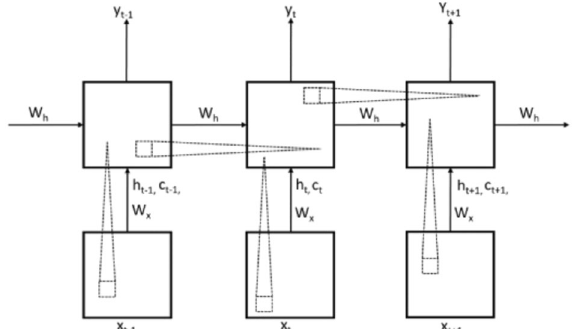
Fig. 18 Convolution operations within LSTM cells